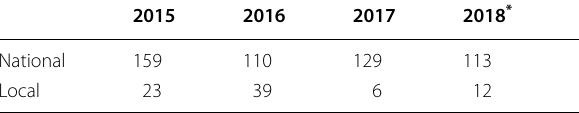
Table 4 Number of documents per national and local level